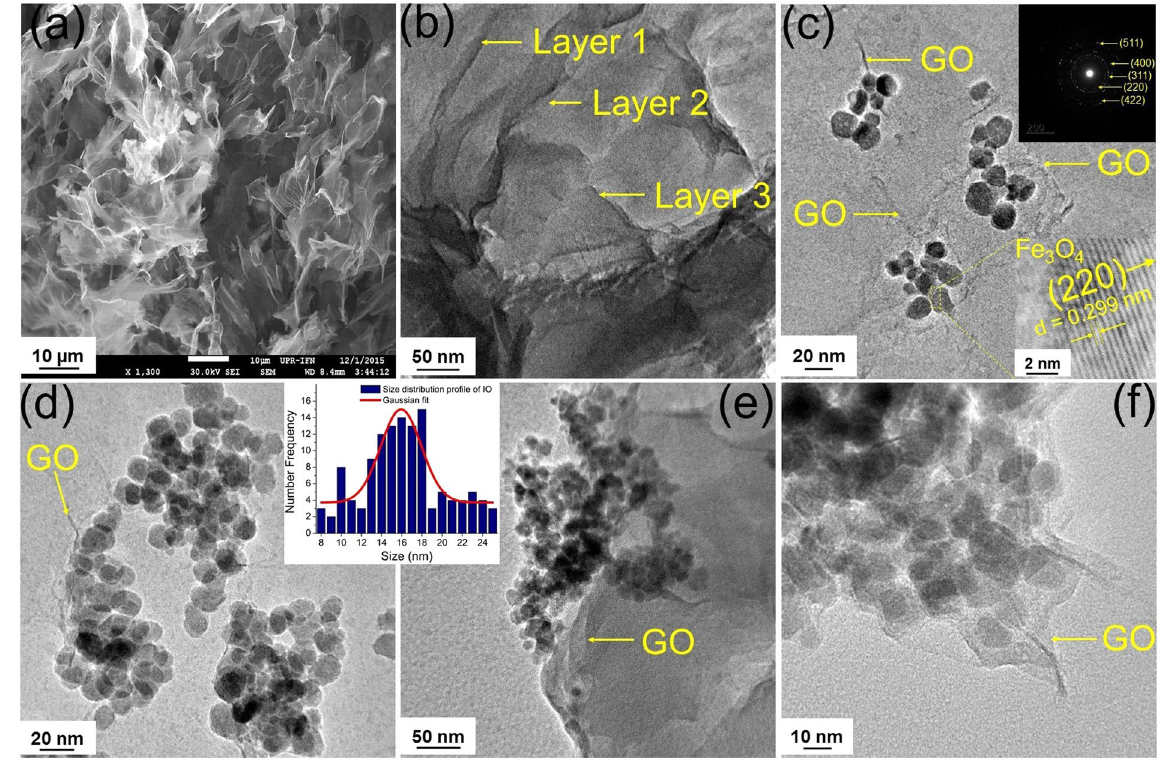
Figure 2. FE-SEM image of ( a ) as-synthesized GO. TEM images of ( b ) as-synthesized GO; ( c ) MGO 1 (8% IO@ GO), inset top right: selected area electron diffraction (SAED) pattern of IO, inset bottom right: HR-TEM image showing lattice fringes of (220) plane of magnetite (Fe 3 O 4 ) phase; ( d ) MGO 2 (18% IO@GO); ( e ) MGO 3 (28% IO@GO); and ( f ) MGO 4 (32% IO@GO). Inset of Fig. 2d,e corresponds to the size distribution profile of IO particles